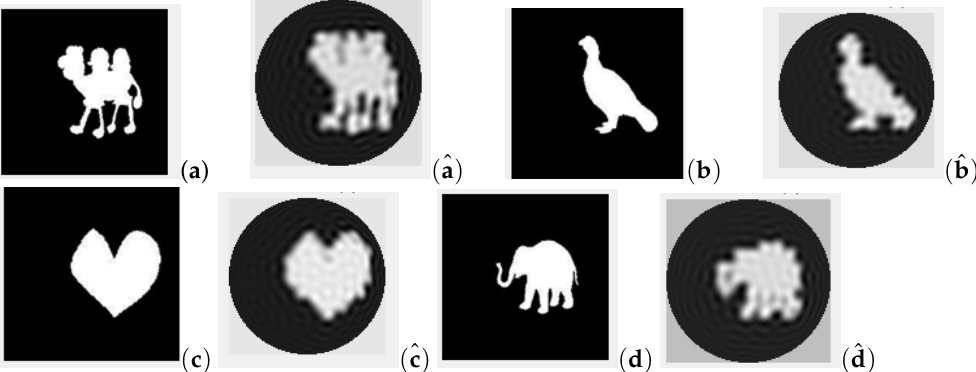
Figure 2. Information expression of pseudo-Zernike moments for images. ( a – d ) are the original images. ˆ ( a – ˆ d ) are reconstructed images of ( a – d ) using pseudo-Zernike moments,